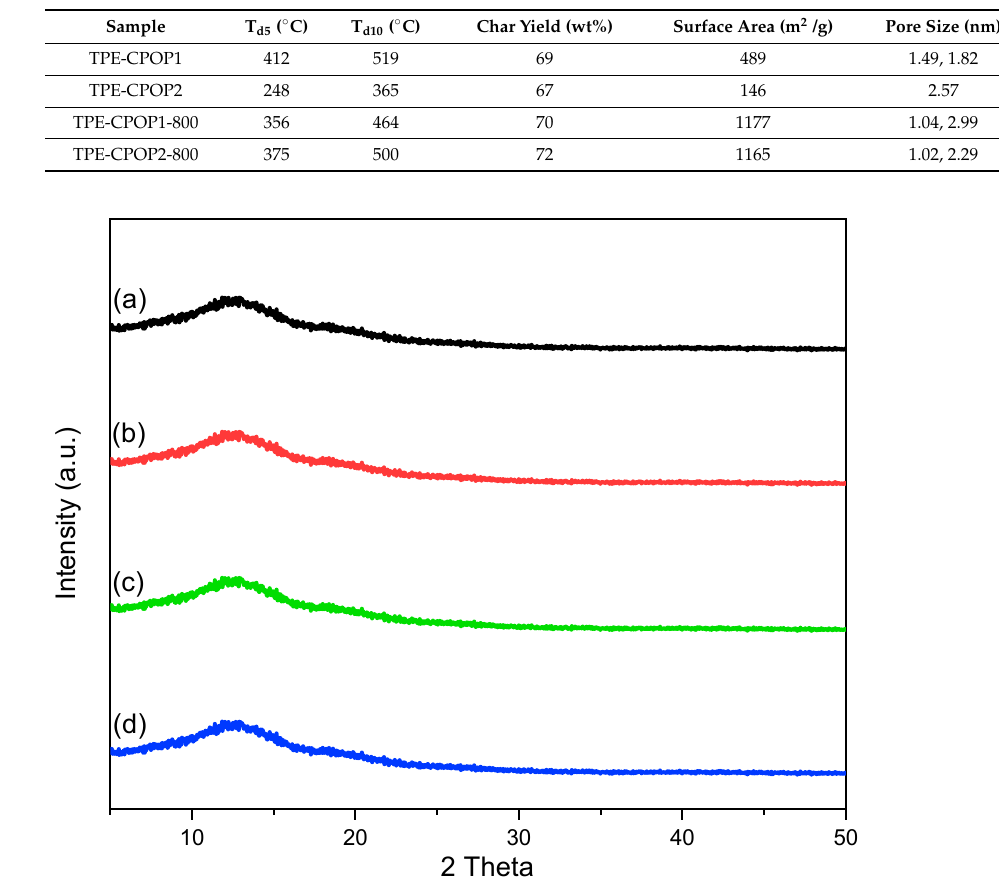
Figure 4. PXRD pattern of ( a ) TPE-CPOP1 and ( b ) TPE-CPOP2, ( c ) TPE-CPOP1-800, and ( d ) TPE-